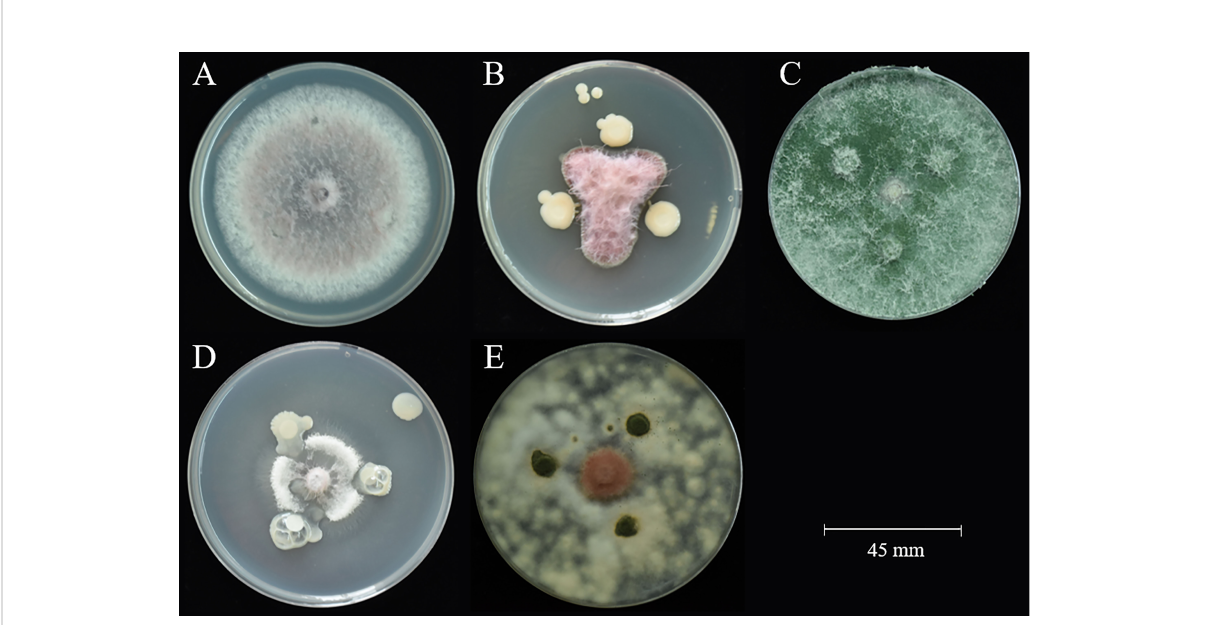
FIGURE 5 Antagonistic activity against F. oxysporum . (A) control F. oxysporum ; (B) SR379 vs. F. oxysporum ; (C) SR38 vs. F. oxysporum ; (D) SR343 vs. F. oxysporum ; (E) SR55 vs. F. oxysporum